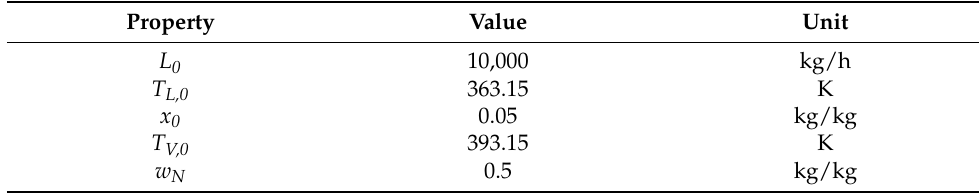
Table 1. Nominal operating conditions.